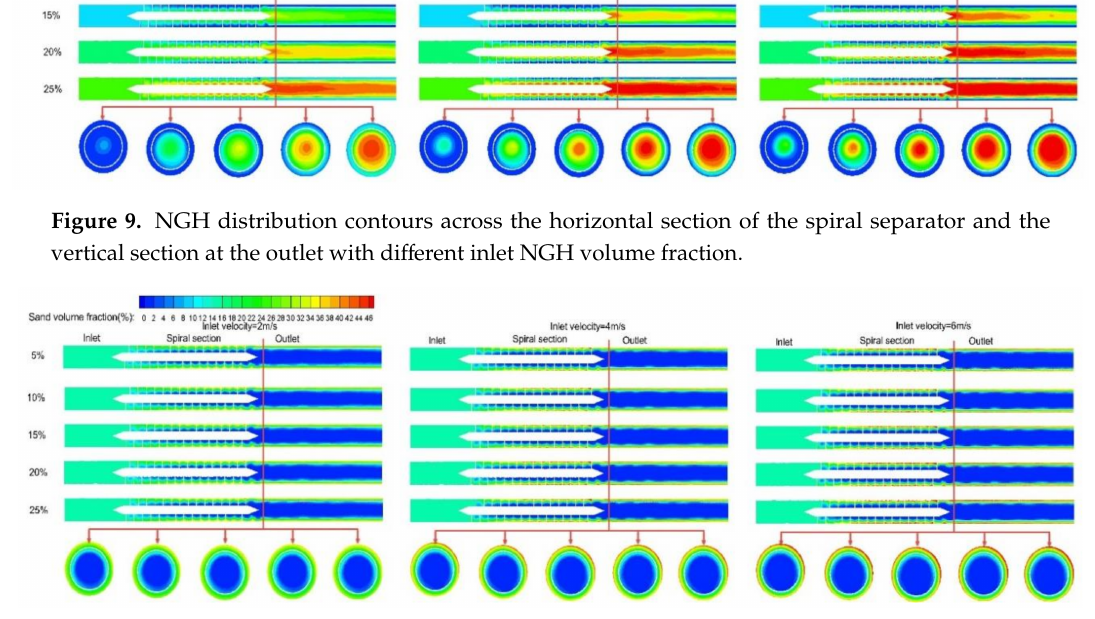
Figure 10. Sand distribution contours across the horizontal section of the spiral separator and the vertical section at the outlet with di ff erent inlet NGH volume